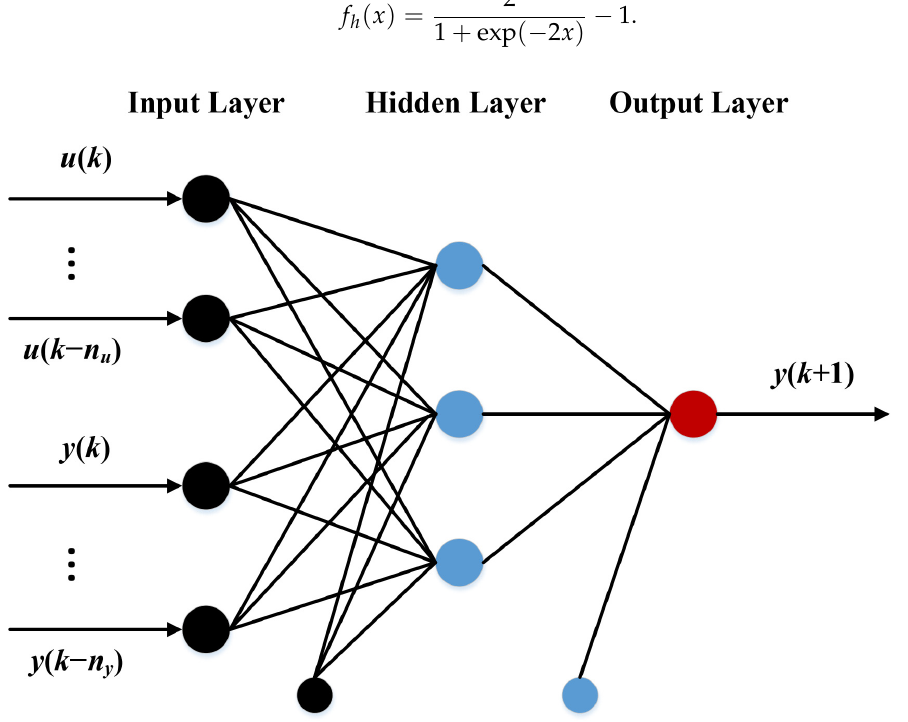
Figure 5. Schematic diagram of the developed FNN.